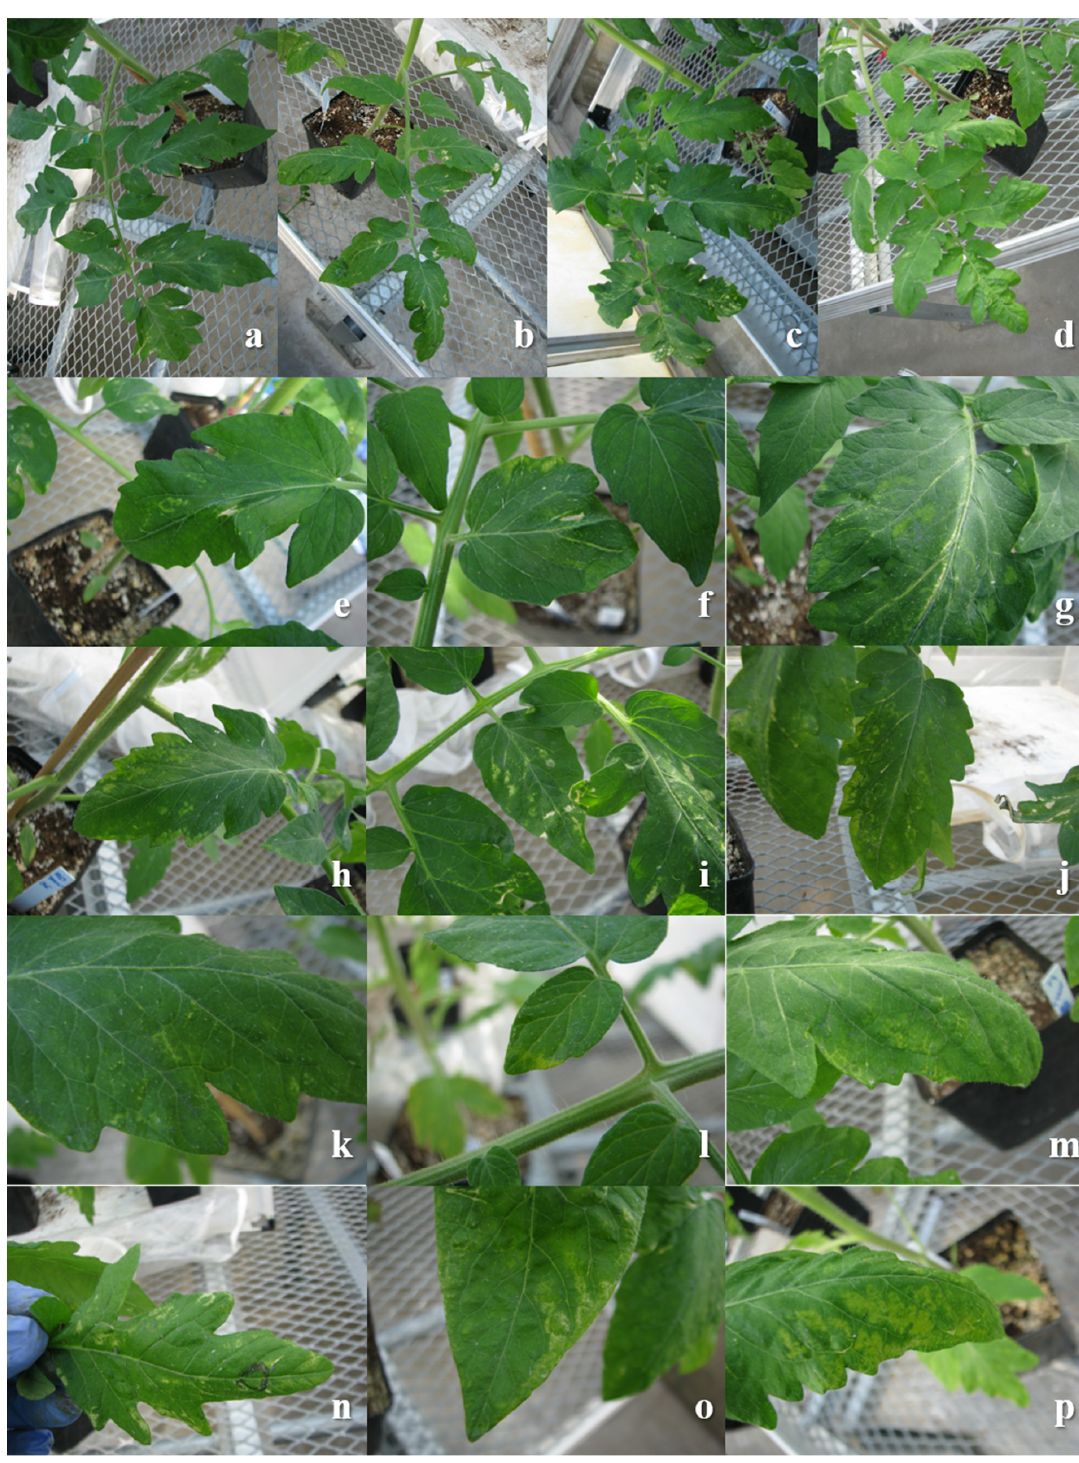
Figure 1. Symptoms expressed on leaf # 3 of tomato cv. Red Defender Sw -5(+) or cv. Marglobe Sw -5(−) 8 days post-inoculation with Tomato spotted wilt virus (TSWV) or mock-inoculated (phosphate buffer). a : Red Defender-mock; b : Marglobe-mock; c : Red Defender-TSWV; d : Marglobe-TSWV. a – d : panoramic view of leaf #3 inoculated with either TSWV or Mock. e – j : Red Defender expressing TSWV localized symptoms; k – p : Marglobe expressing TSWV localized symptoms.